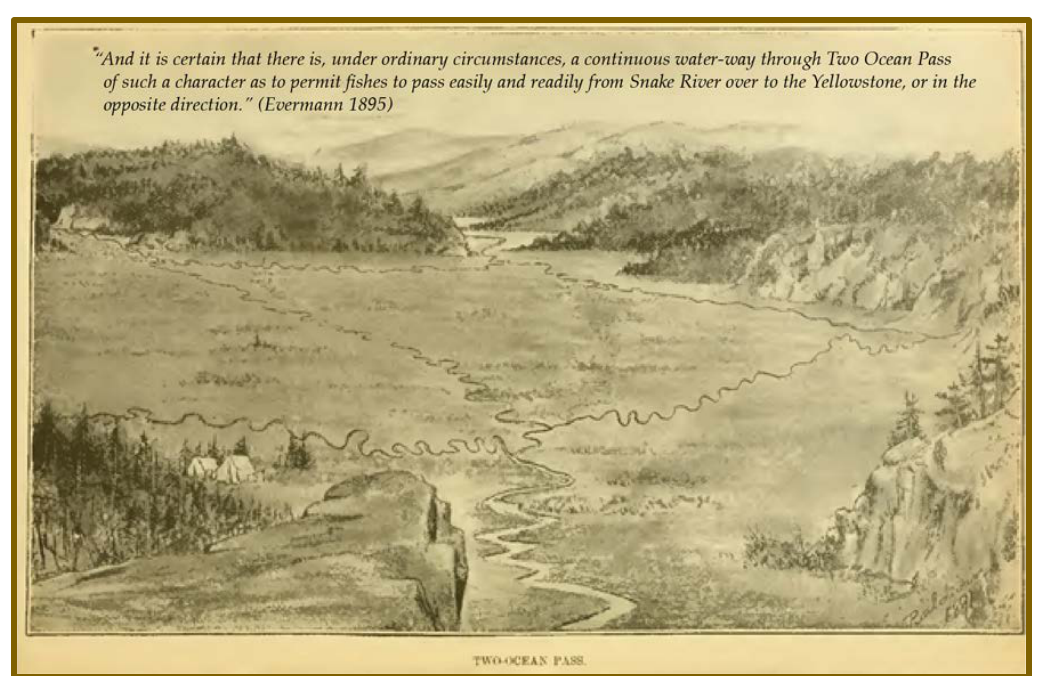
Figure 2. Sketch of Two Ocean Pass with a view to the northeast in 1891, recreated from [14,15]. Atlantic Creek is shown exiting the pass between the hills in the upper part of the image. Pacific Creek exits to the southwest in the lower part of the image. North Two Ocean Creek enters from the left side of the image and divides into its two distributaries. South Two Ocean Creek enters from the right of the image and apparently also divided into two distinct streams at that time. The pass is a nearly level meadow near the center, which is a marsh that becomes a small lake in times of wet weather or snowmelt runoff [14,15].